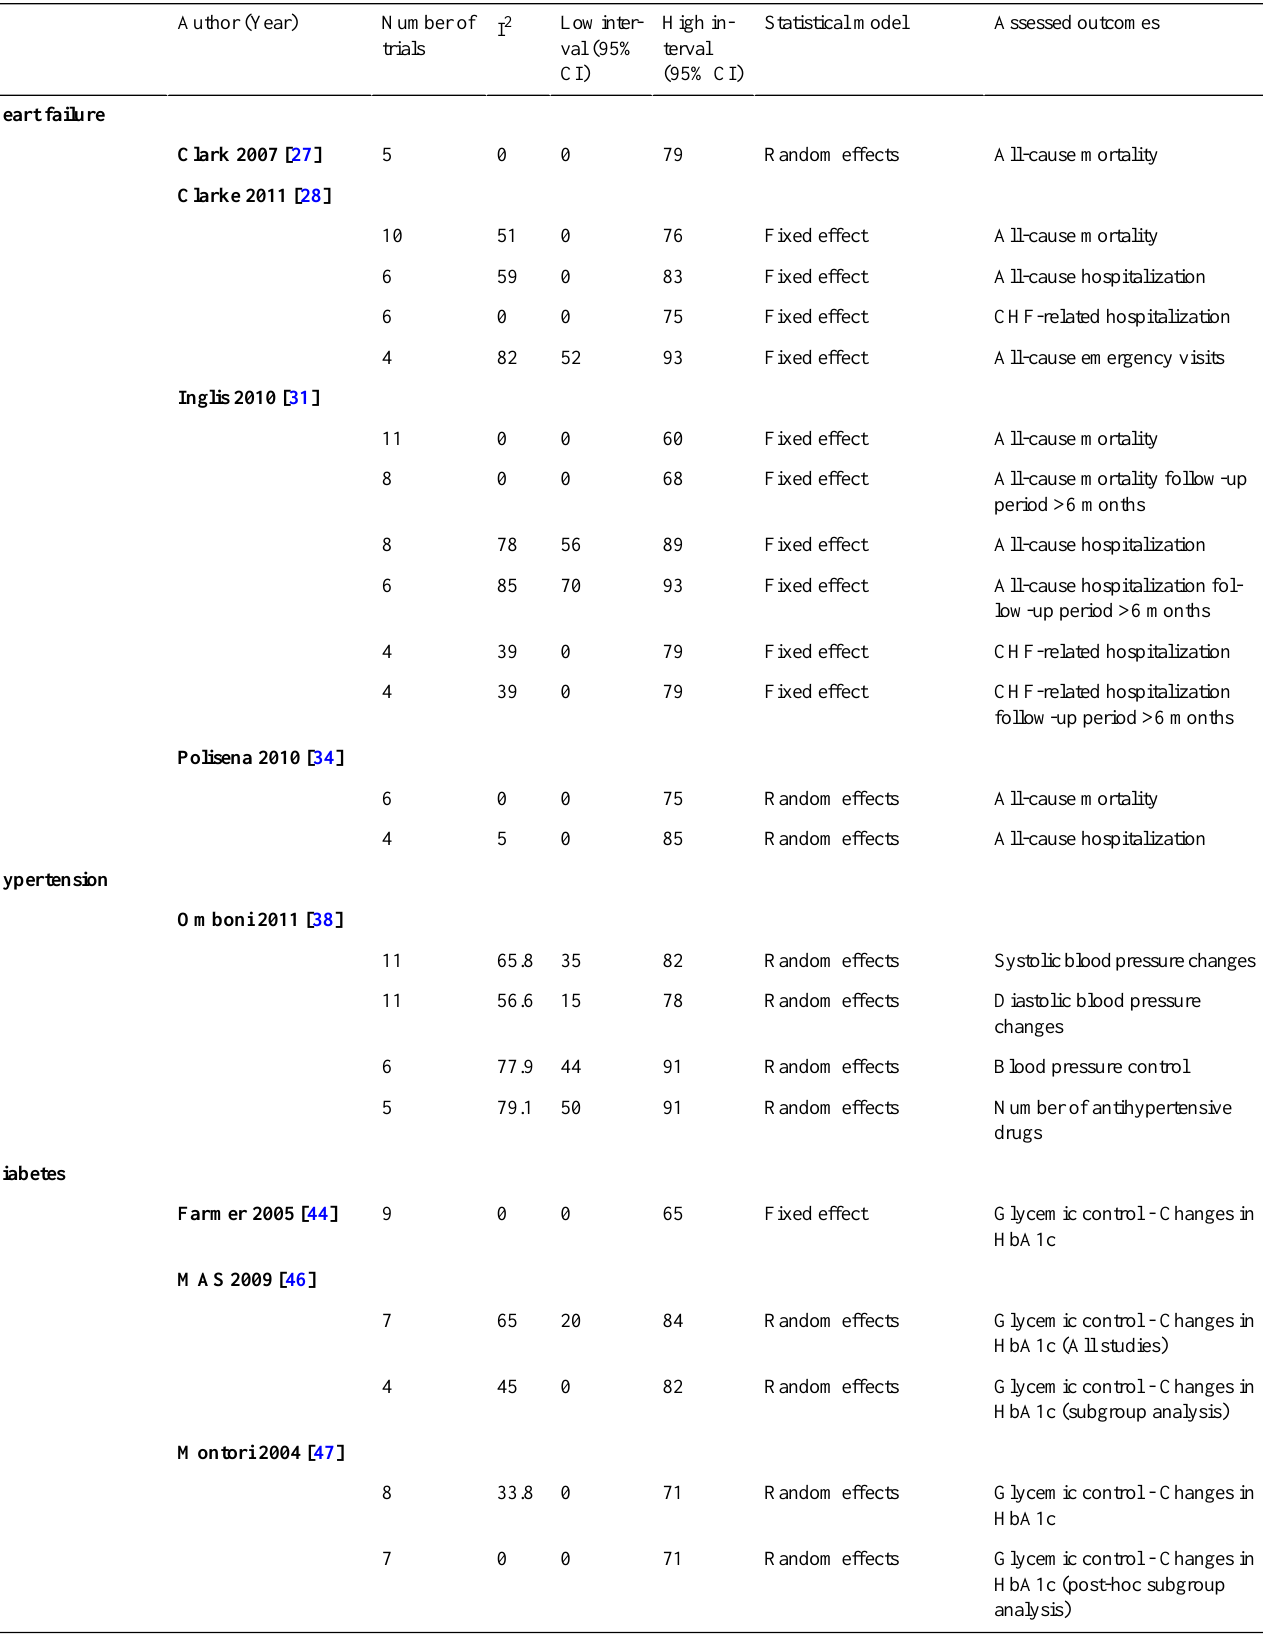
Table 6. Confidence intervals for the I 2 estimates of